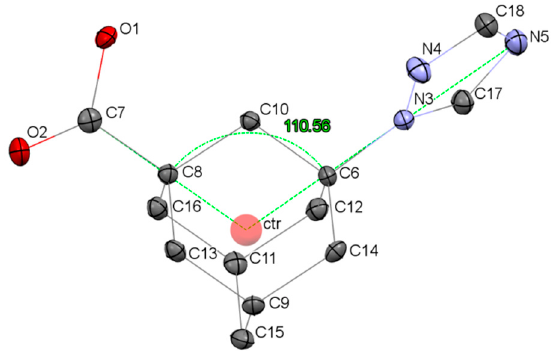
Figure 1. The structure of the compound trzadcH showing adamantane centroid (ctr) and φ CctrN angle. H atoms are omitted.